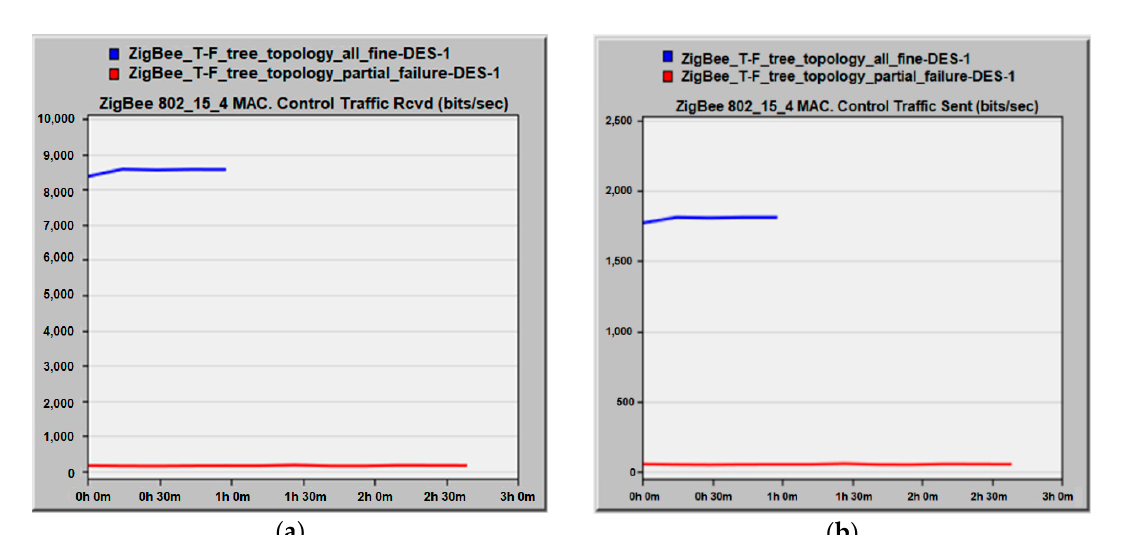
Figure 5. ( a ) Received control traffic in bits per second; ( b ) Sent control traffic in bits per second.